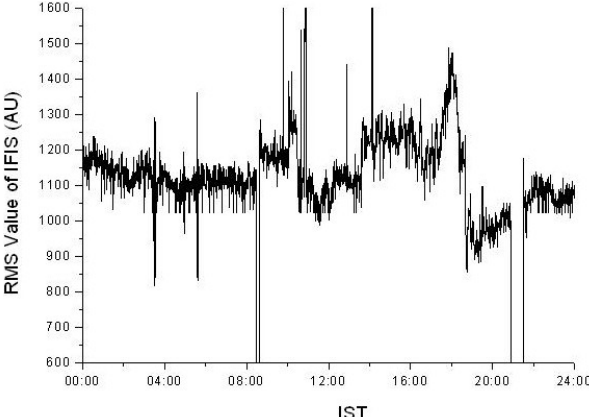
Fig. 6. A record of IFIS in relation to thunderstorm activity in south Tripura at a distance 40–50km from the receiving station.